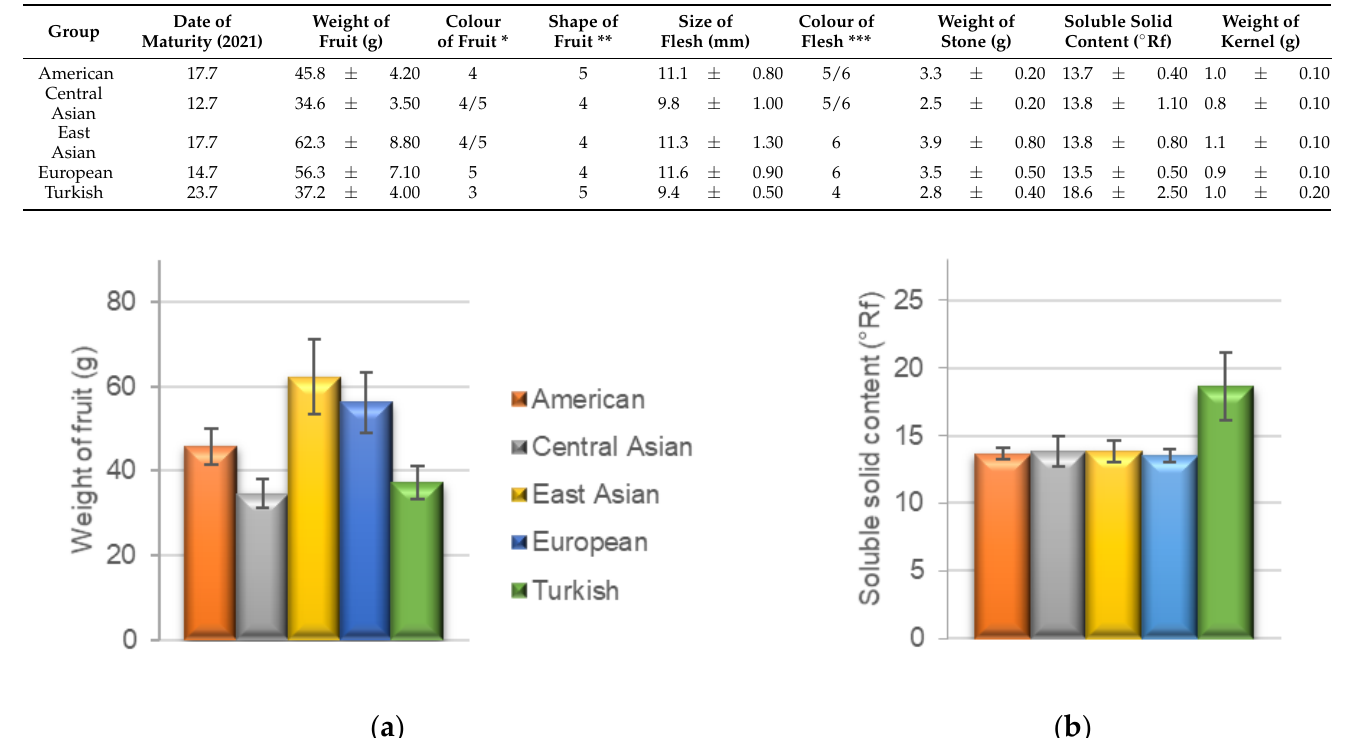
Figure 1. ( a ) The average weight of fruit (g); ( b ) The average soluble solid content of the fruit (°Rf) in the selected geographical groups of apricot cultivars. Table 3. The nuclear DNA content and monoploid genome sizes of the selected cultivars with dif- ferent geographical origins.